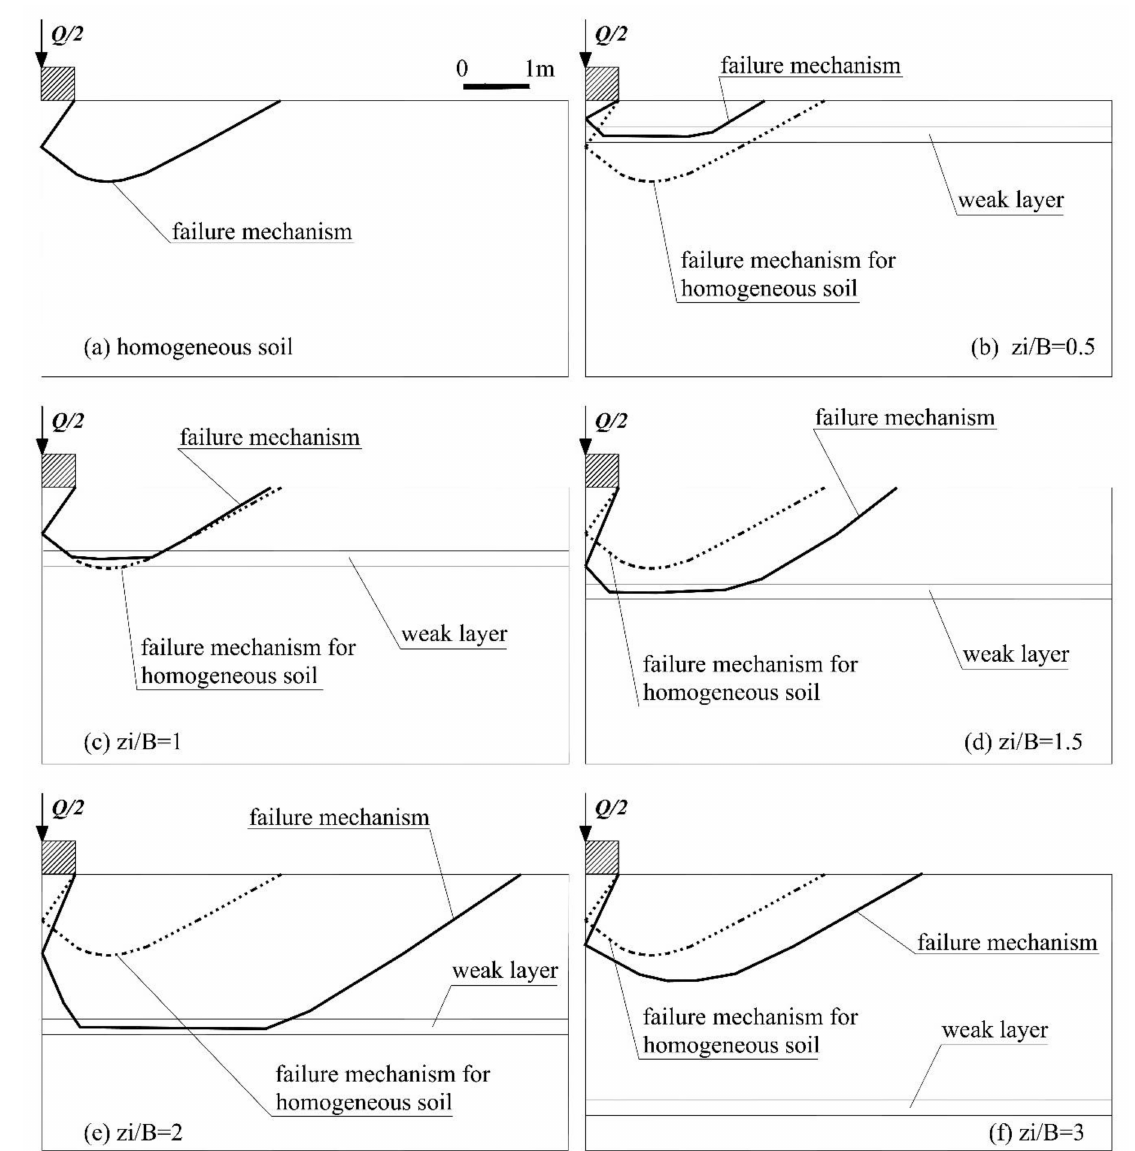
Figure 10. Failure mechanism for ϕ (cid:48) 1 = 40 ◦ , ψ (cid:48) 1 = (2/3) ϕ (cid:48) 1 = 26.7 ◦ (sand), ϕ (cid:48) 2 = 15 ◦ , ψ (cid:48) 2 = 0 (weak layer) as a function of the relative depth and z i /B of the weak layer (B = 1 m). For comparison, the failure mechanism of the case of homogeneous soil is represented in all